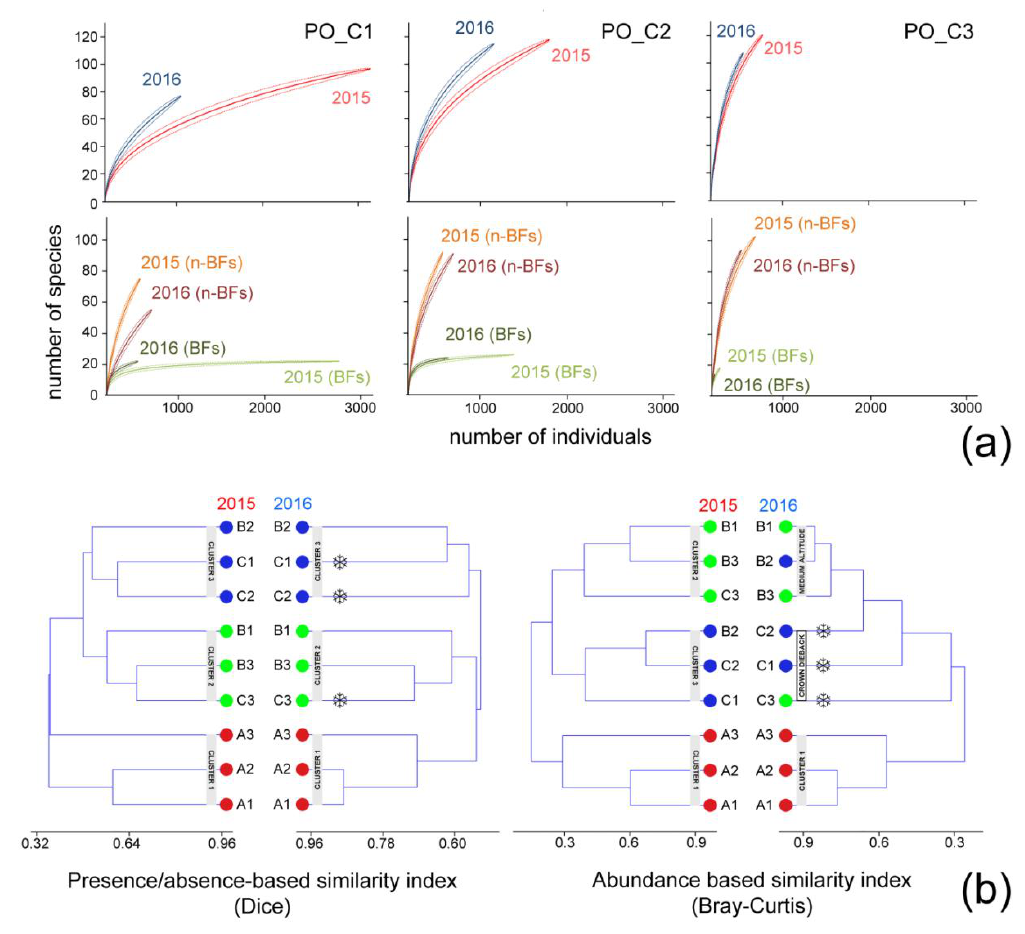
Figure 5. Comparisons of moth communities sampled before (2015) and after (2016) the extreme weather event (EWE). (a) Individual-based rarefaction curves with standard deviation (dotted lines) of communities sampled within stands showing crown dieback (PO_C1-2-3). Communities were analyzed as a whole and partitioned into beech feeders (BFs) and non-beech feeders (n-BFs). (b) Cluster analysis (paired group) performed on autumn samples. Communities constituting a cluster before the EWE are indicated by circles of the same color and maintained as a reference for a given stand. Snowflakes mark stands showing crown dieback.